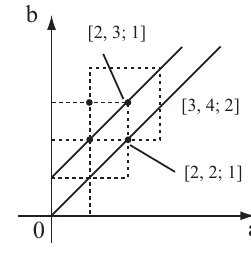
Figure 6 . Division of a